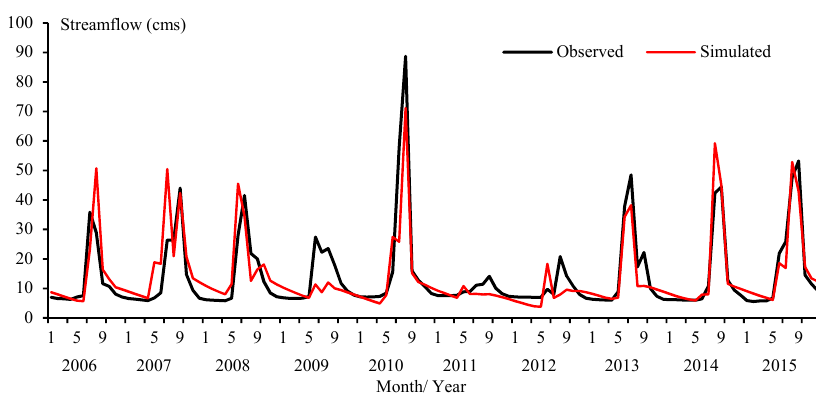
Figure 5. Soil and Water Assessment Tool (SWAT)-1 model simulated monthly streamflow at the outlet of the middle reach.